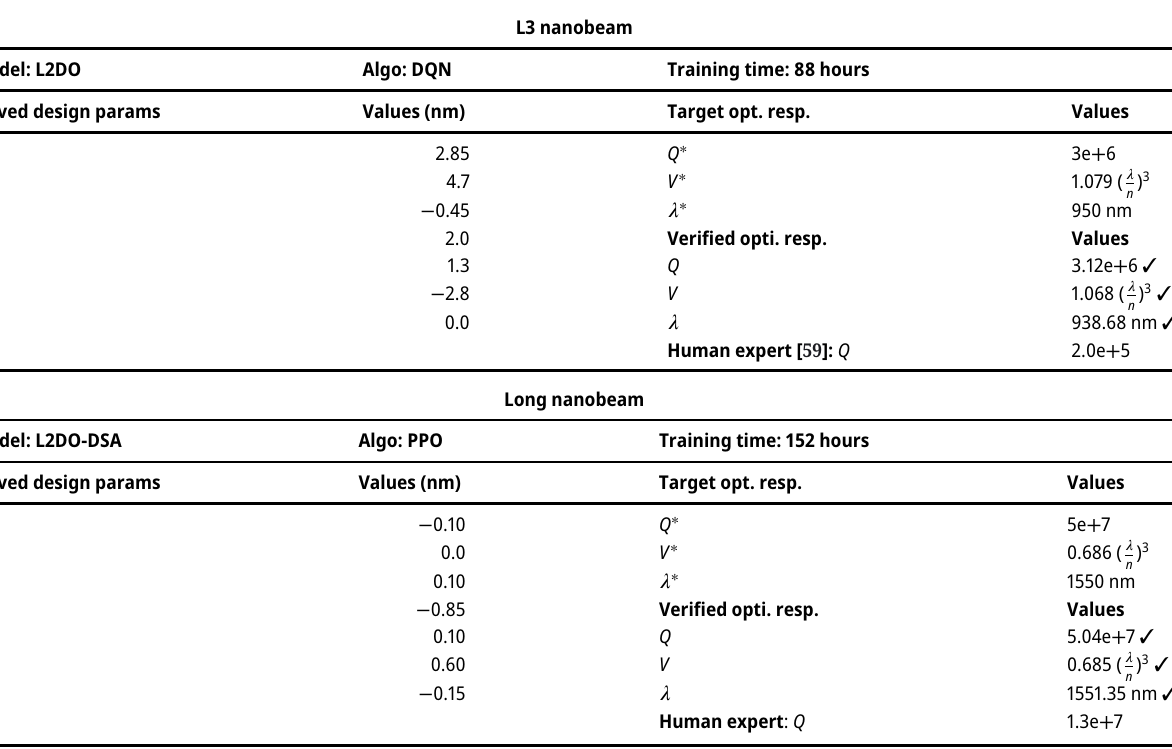
Table 2: L2DO-retrieved unique set of design parameters for the L3 nanobeam (top) and long nanobeam (bottom), respectively, are shown in the first two columns. Target optical responses are marked with stars. Also tabulated are the FDTD-verified optical responses using the solved design parameters (check-marked) and human expert-reported values. The model, algorithm (algo), and total training time of each nanobeam are written in the Table, as